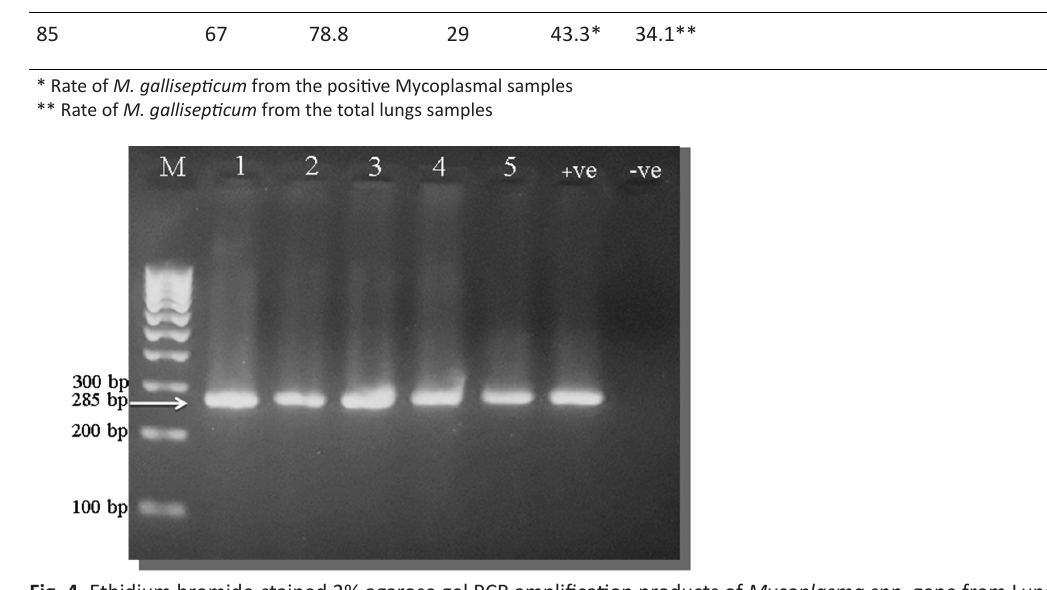
Table 4. Presence of Mycoplasma in starlings lungs according to PCR results No. Lungs Mycoplasma